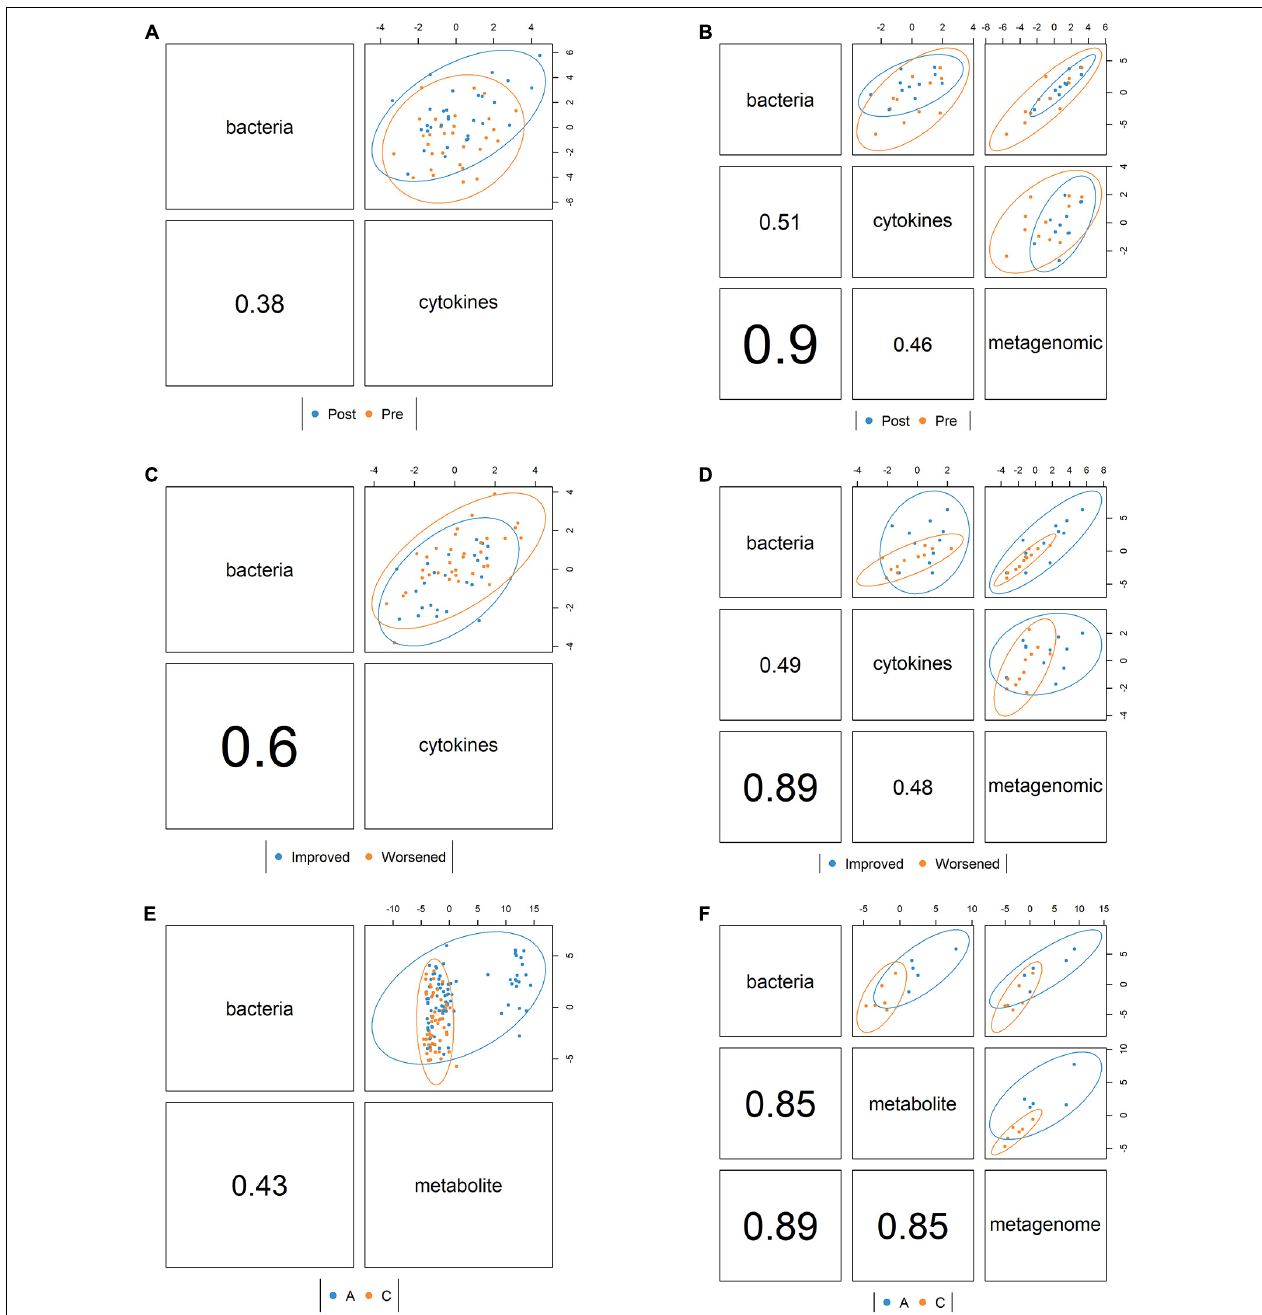
FIGURE 3 | Correlation structure between datasets as determined by the mixOmics DIABLO framework colored by pre- vs . posttreatment for the periodontal treatment (PT) study (A) bacterial 16S and cytokine datasets and (B) bacterial 16S, cytokine, and metagenomic datasets and also colored by whether the disease improved or worsened for (C) the bacterial 16S and cytokine datasets and (D) the bacterial 16S, cytokine, and metagenomic datasets. For the sodium hypochlorite (SHT) study, samples were colored by disease class for (E) the bacterial 16S and metabolic datasets and (F) the bacterial 16S, metabolites, and metagenomic datasets. Values indicate the between-dataset correlation structure. Ellipses indicate discrimination by the multiomics components between samples by